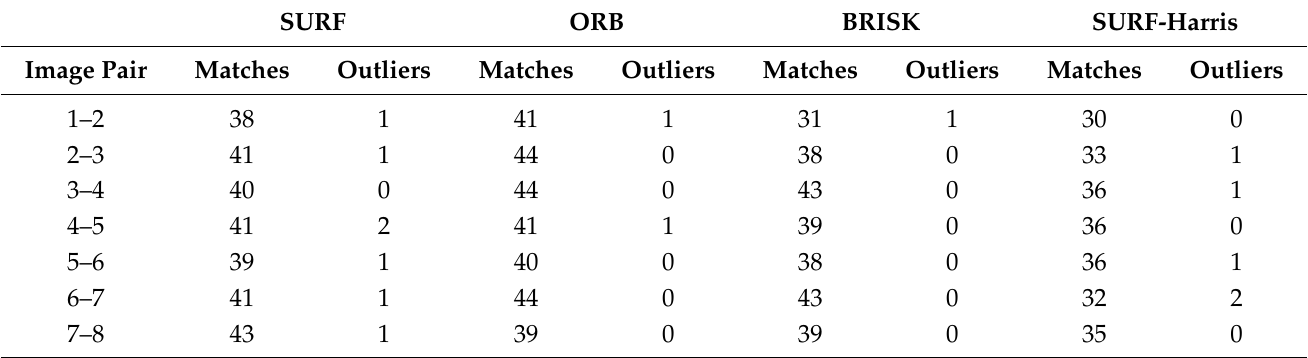
Table 7. Number of matches performed and corresponding number of outliers for dataset 1 employing the selection module.